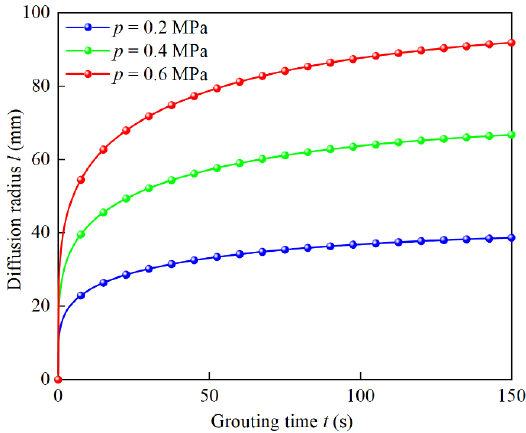
Figure 10. Influence of grouting pressure on diffusion radius.